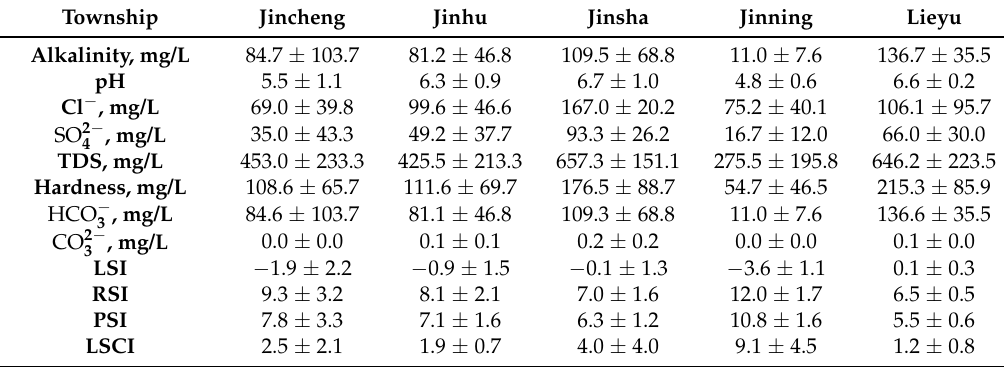
Table 6. Summary of chemical analysis and the water quality index for ground water in Kinmen.